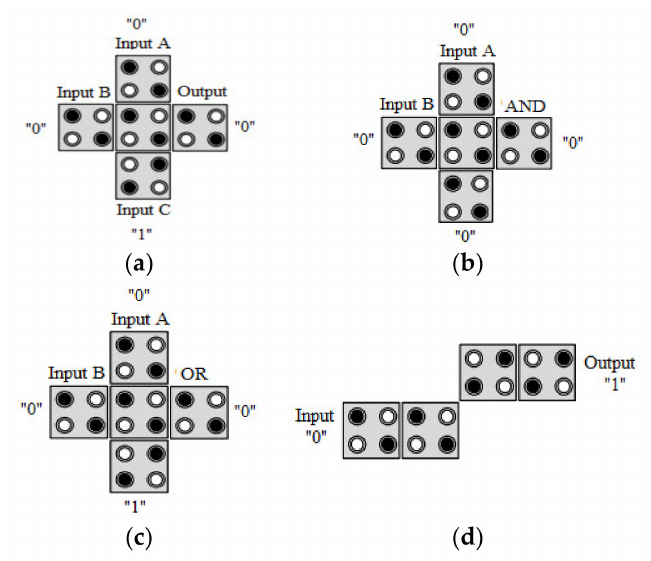
Figure 4. ( a ) MV, ( b ) two-input AND, ( c ) two-input OR, and ( d ) inverter